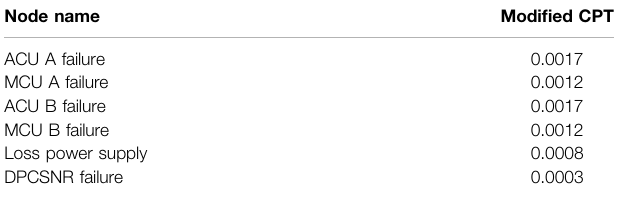
TABLE 4 | Modi fi ed CPT in the DBN model.